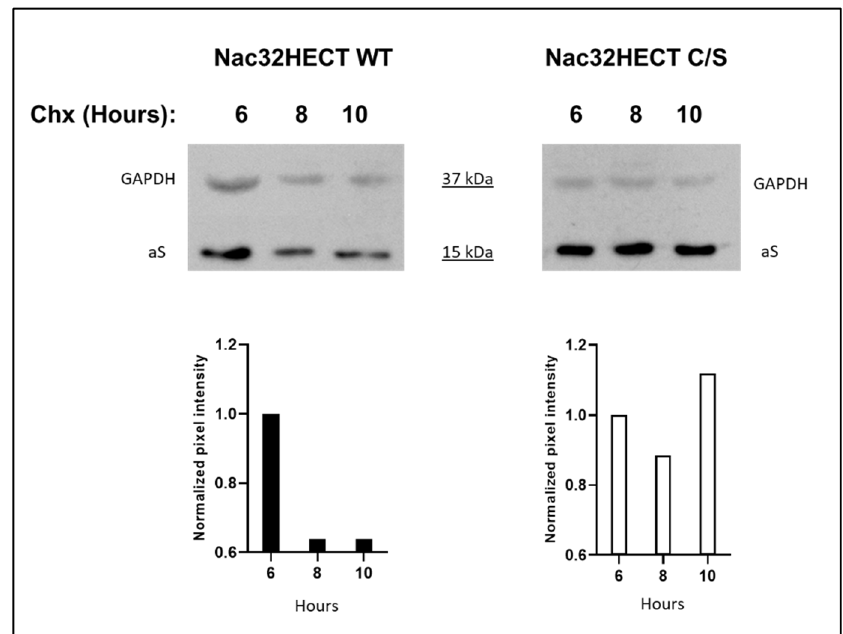
Figure 9. Intracellular amounts of endogenous aS are affected by Nac32HECT expression in neuroblastoma-derived cells. SH-SY5Y cells were transduced with RLPs expressing Nac32HECT WT or Nac32HECT C/S. Twenty-four hours later, cells were incubated in fresh medium containing 20 µ g/mL cycloheximide (Chx), harvested at 6, 8, and 10 h post-treatment, as indicated and lysed. A western blot was performed by adopting an anti-GAPDH and an anti-aS antibody. Values reported in the graphs below each western blot represent the ratio of the pixel intensity of the target protein band to that of the respective loading control, with the ratio calculated for 6 h post-treatment set to 1. Quantification of band intensities was conducted by densitometry analysis (ImageJ software; version number 1.51j).